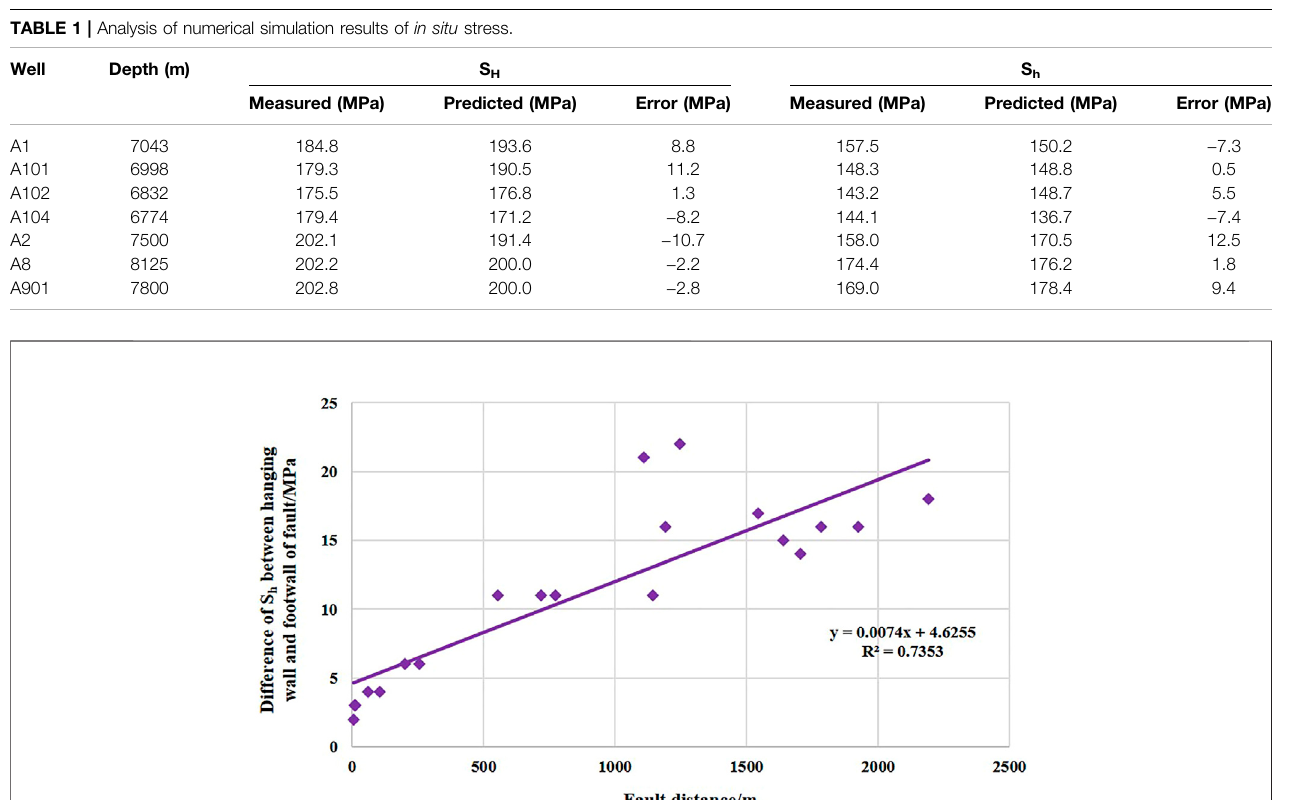
FIGURE 8 | Relationship between thrust fault distance and the difference of minimum horizontal principal stress between the hanging wall and footwall.